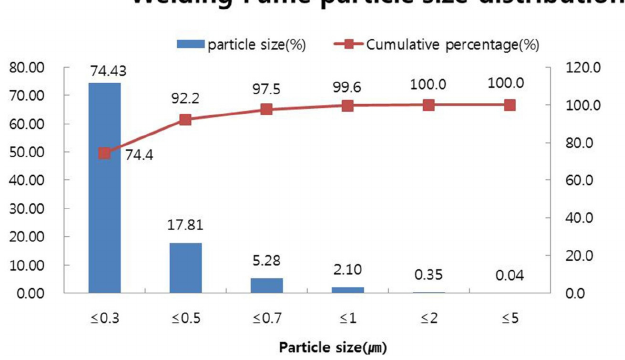
Figure 5. Size distribution of welding fume particles (%).